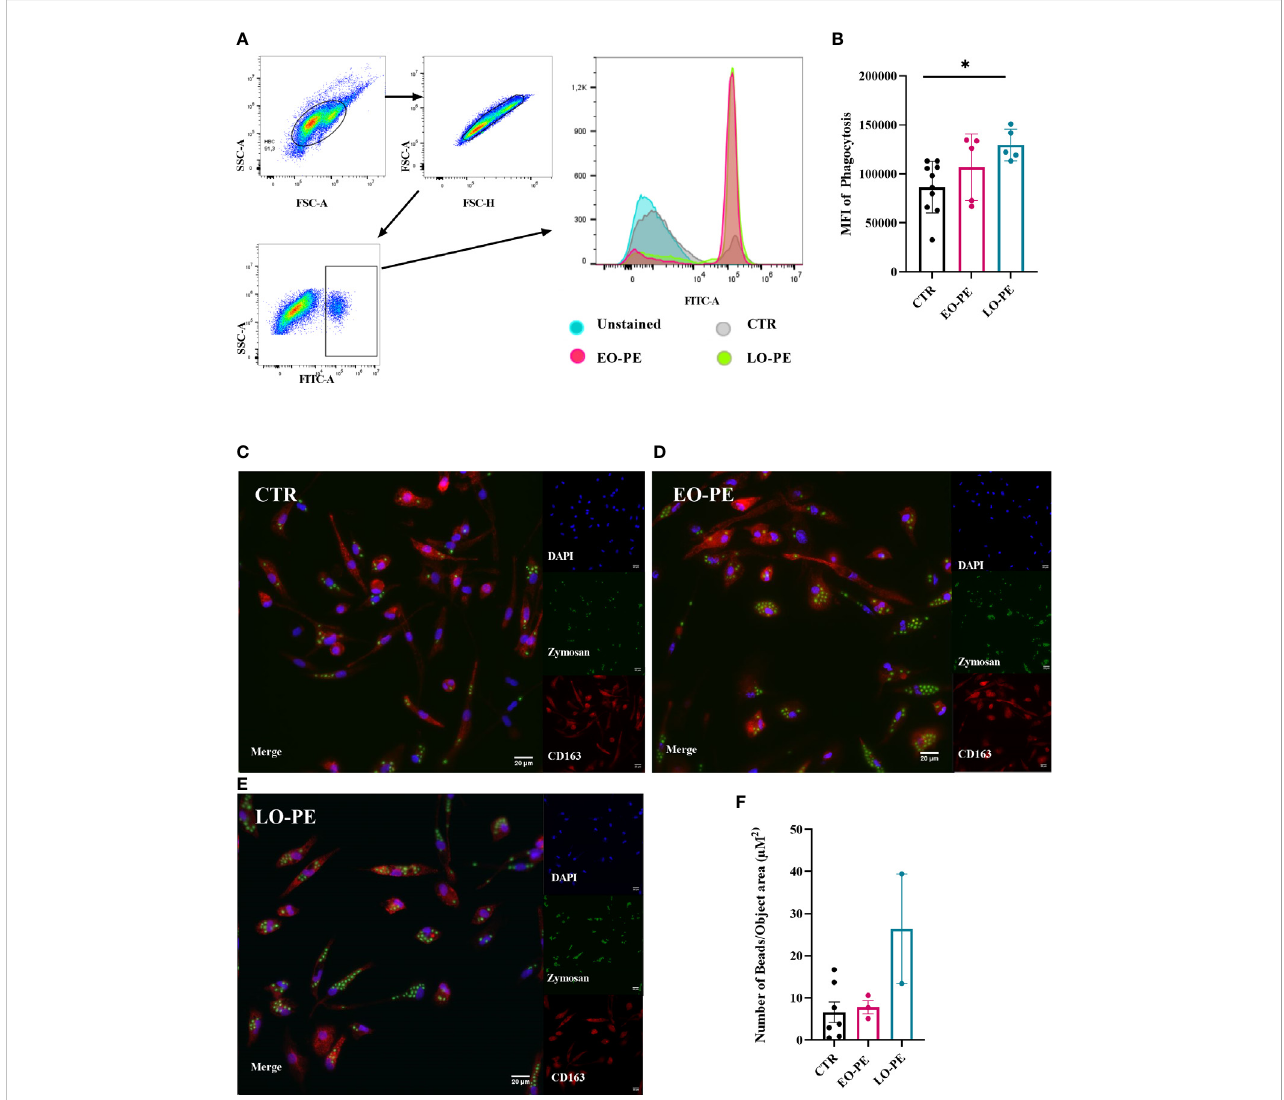
FIGURE 4 PE HBCs possess a higher phagocytic capacity. (A) Gating strategy cells for the measurement of phagocytosis. Cells were separated by size using forward and size scatter (FSC and SSC, respectively), followed by doublet discrimination and gating against SSC-area and FITC -A fl uorescent signal. Histograms of one representative experiment are shown, in total 10 CTR, 5 EO-PE and 5 LO-PE HBCs were used. (B) Quanti fi cation of median fl uorescence intensity (MFI) of phagocytosis measured with FACS. (C) Visualization of phagocytosis with high content screening microscopy (HCS). HBCs were treated with zymosan beads (green) and co-stained with CD163 (red), DAPI was used to stain nuclei. Representative images of individual experiments are shown. To visualize phagocytosis CTR ( C , n=7), EO-PE ( D , n=3) and LO-PE ( E , n=2) isolations were used. Scale bar represents 20µM. (F) Quanti fi cation of the phagocytosis measured with high content screening. Analysis was carried out with NisViewer Software, analyzing the number of beads within the CD163 positive HBC cell. All data in (B, F) are presented as mean ± S.E.M, ANCOVA with adjustment for gestational age with Sidak ’ s post-hoc test was used for to test statistical signi fi cance. *p ≤